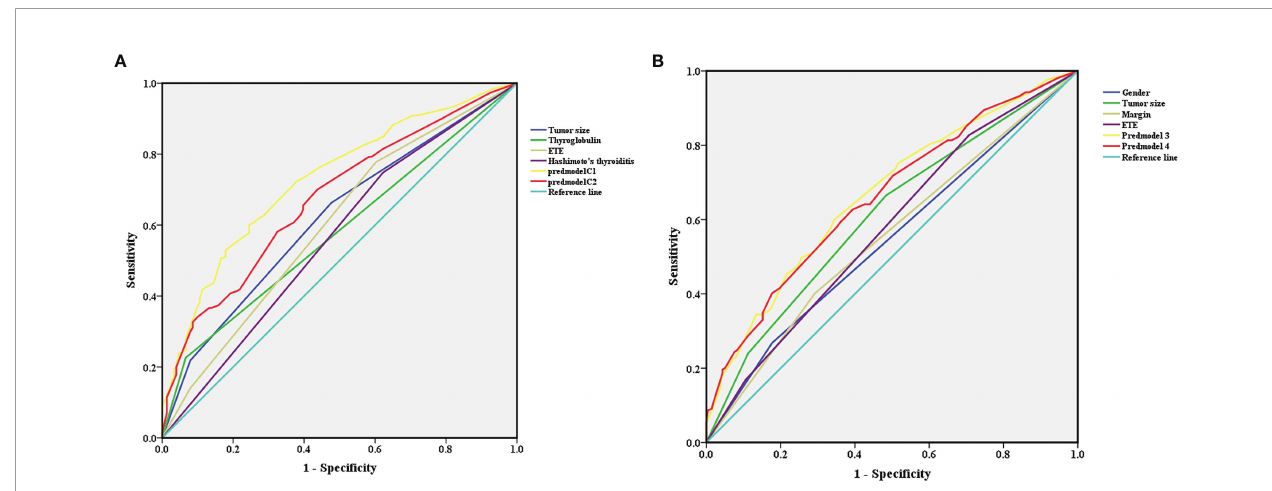
FIGURE 5 | (A) In the subgroup with age <45 years, receiver operating characteristic analysis demonstrated an area under the curve(AUC) of 0.729 (95% CI 0.680- 0.777; P<0.05). (B) In the subgroup with age ≥ 45 years, receiver operating characteristic analysis demonstrated an AUC of 0.668 (95% CI 0.619-0.716; P<0.05).